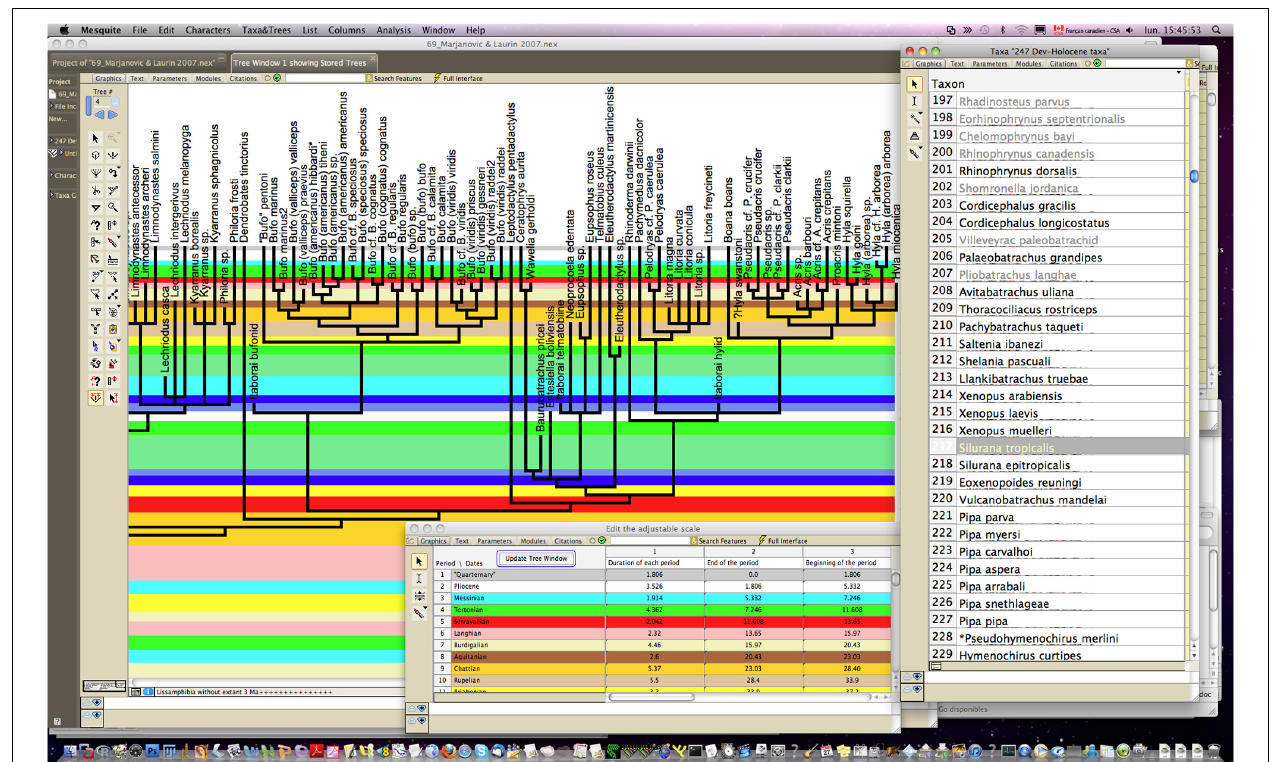
FIGURE 3 | Interface of StratigraphicTools (Josse etal., 2006) for Mesquite (Maddison and Maddison, 2011). Screen capture showing a small part of a paleontological timetree.The geological timescale is user-specified through a dialog window (shown at the bottom) in StratigraphicTools; users